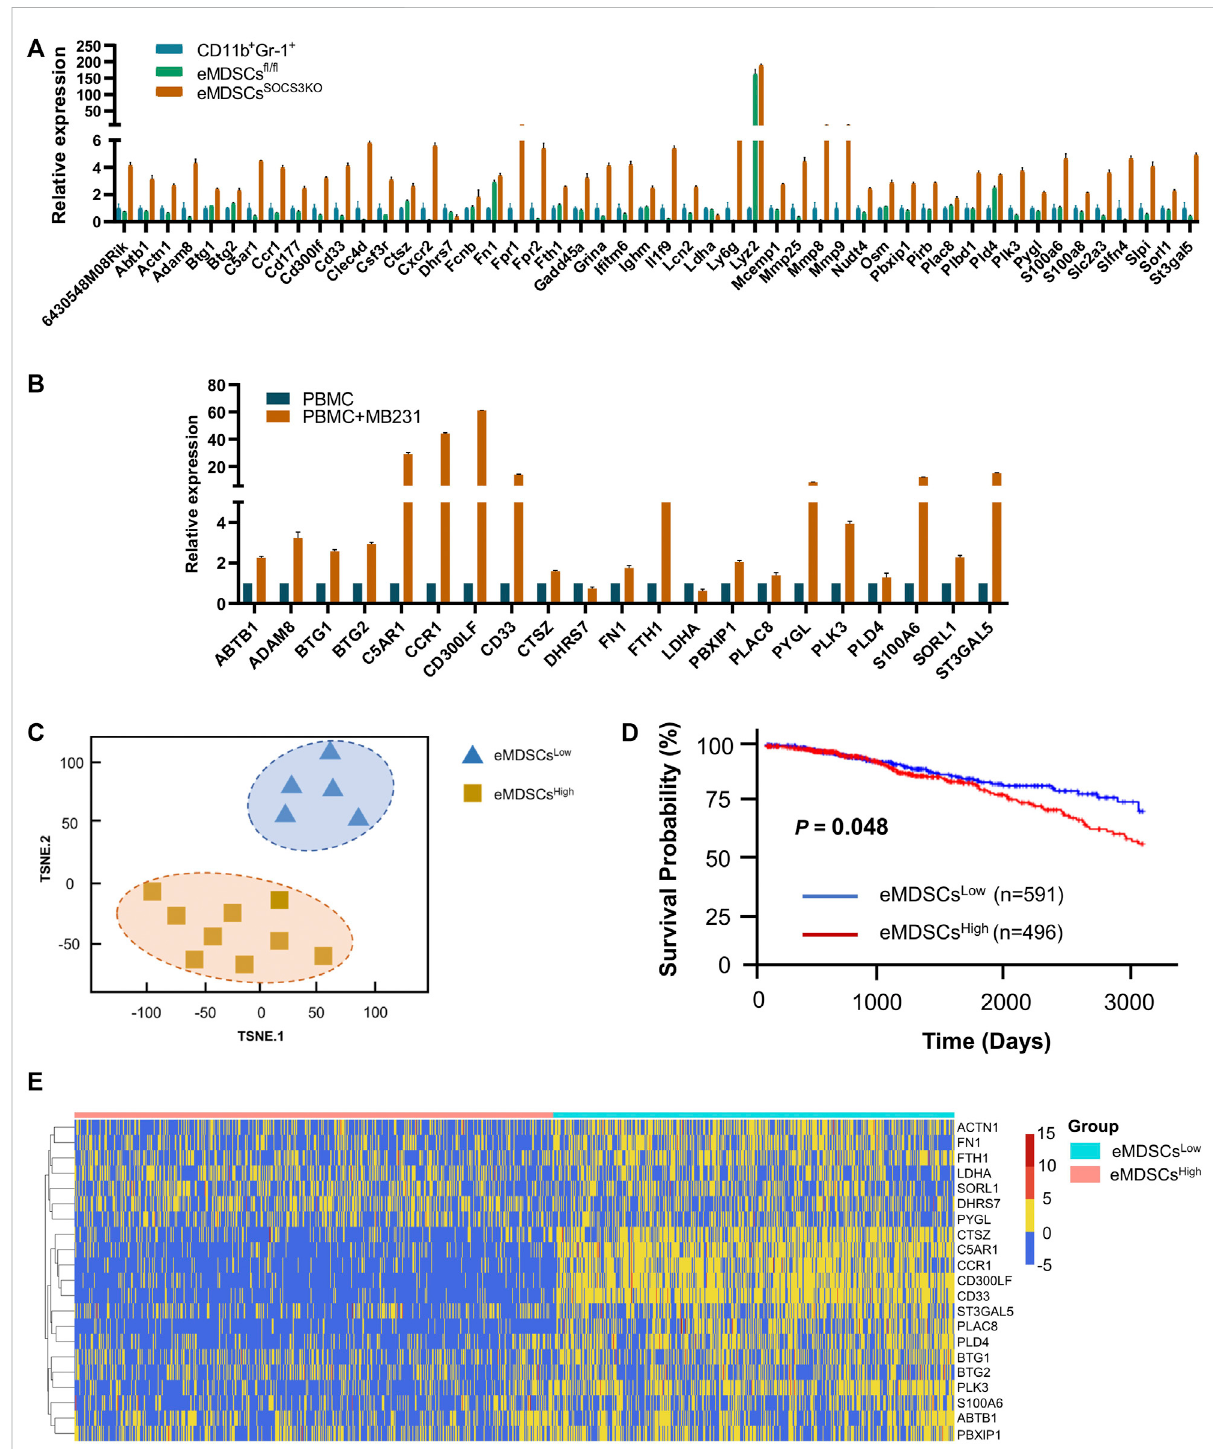
FIGURE 1 The 21-genes signature is able to predict the in fi ltration of eMDSCs in situ . (A) The relative expression of 50 genes that can separate the three groups of eMDSCs SOCS3KO , CD11b + Gr-1 + and eMDSCs fl / fl cells. (B) The relative expression of 21 genes in human PBMC-derived eMDSCs was con fi rmedbyRT-qPCR.Thetranscriptionalpatternsof21genesarecomparablebothinhumansandmice.CD33 + myeloidprogenitorsisolatedfrom healthy PBMCs were co-cultured with MDA-MB-231 breast cancer cells to induce eMDSCs. (C) T-SNE analysis was used to visually display the classi fi cation results and the consistency between the 21-genes signature prediction and immunohistochemical observation was as high as 85.7% (12/14). (D) Kaplan-Meier survival analysis of differences between eMDSCs high and eMDSCs low groups in TCGA breast cancer cohort showed that the OSwaslongerintheeMDSCs low groupthantheeMDSCs high group. (E) Heatmapofthe21genesexpressionpro fi